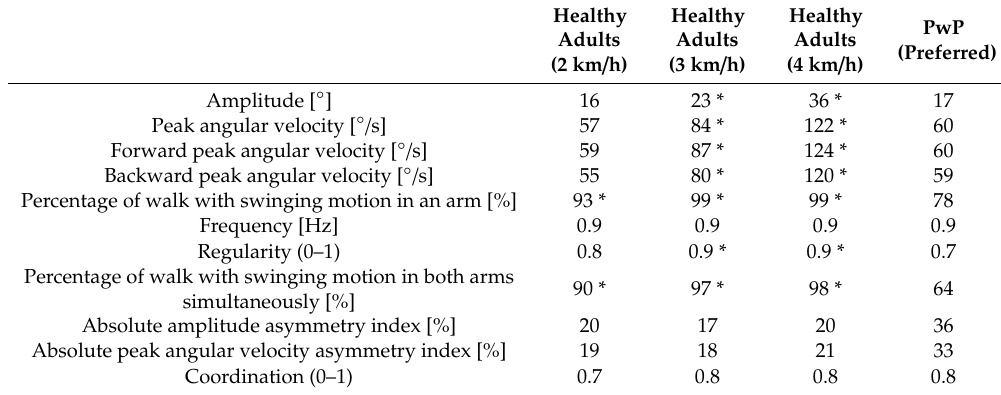
IMU-based arm swing parameters for the healthy adults and the patients with Parkinson’s